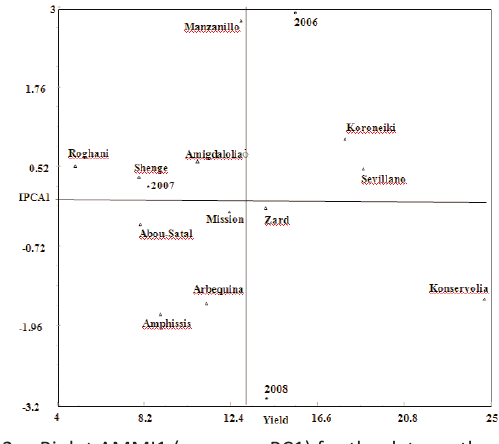
Fig. 2 - Biplot AMMi1 (means vs PC1) for the data on the yield of olive (Ton ha -1 ) with 12 cultivars (  ) and five years